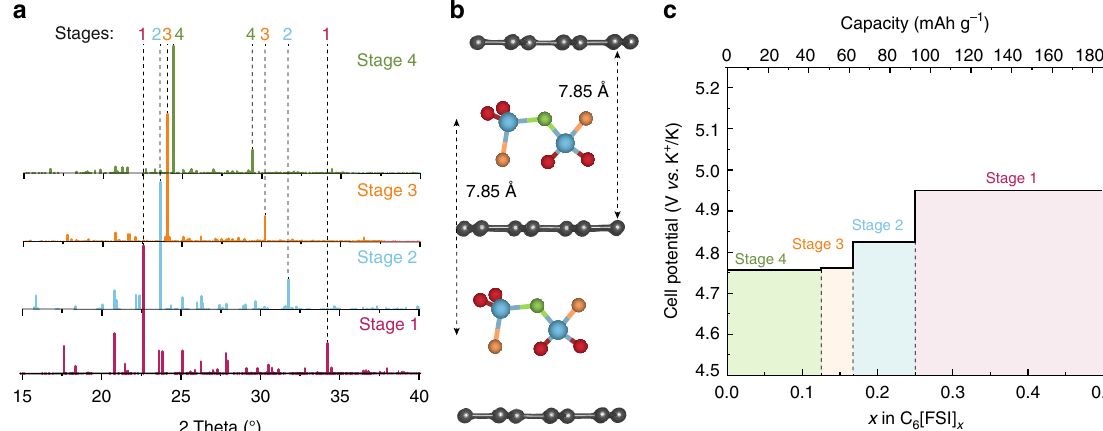
Fig. 2 DFT calculations of FSI − anion intercalation into graphite. a Simulated powder XRD patterns of charged graphite with intercalated FSI − anions in different stages. The dashed lines represent the positions of the most intense peaks for stages 1, 2, 3, and 4. For stage 1, the peak at 2 θ = 20.81° corresponds to the ( 0k0 ) plane, due to the lateral shift of graphite layers (AB stacked) upon FSI − intercalation in the fully charged system. As there is much less shift of AB-stacking for other stages (stages 2, 3, and 4), we did not fi nd any additional peaks for these systems (see Supplementary Fig. 8 and Note 3 for detailed explanation). b Schematic of FSI − anion intercalated into graphite for stage 1 ( n = 1). Fluorine, oxygen, sulfur, and nitrogen atoms representing FSI − anion are shown in brown, red, blue, and green colors, respectively. c Calculated voltage pro fi le of FSI − anion intercalation into graphite as a function of the molar ratio between FSI − and C (i.e., x in C 6 [FSI] x )